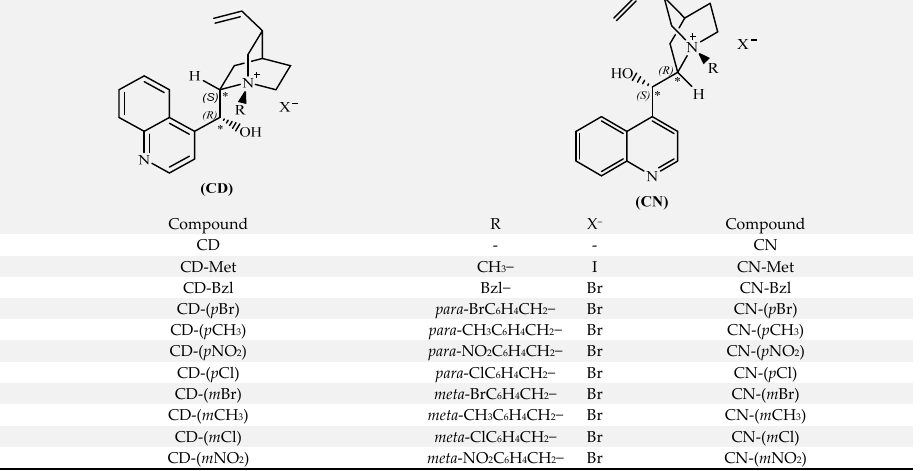
Figure 1. Structures of cinchonidine ( CD ) and cinchonine ( CN ) compounds. Absolute configurations, opposite in quasi ‐ enantiomers at positions 8 and 9, are noted; (8S,9R) in CD and (8R,9S) in CN .